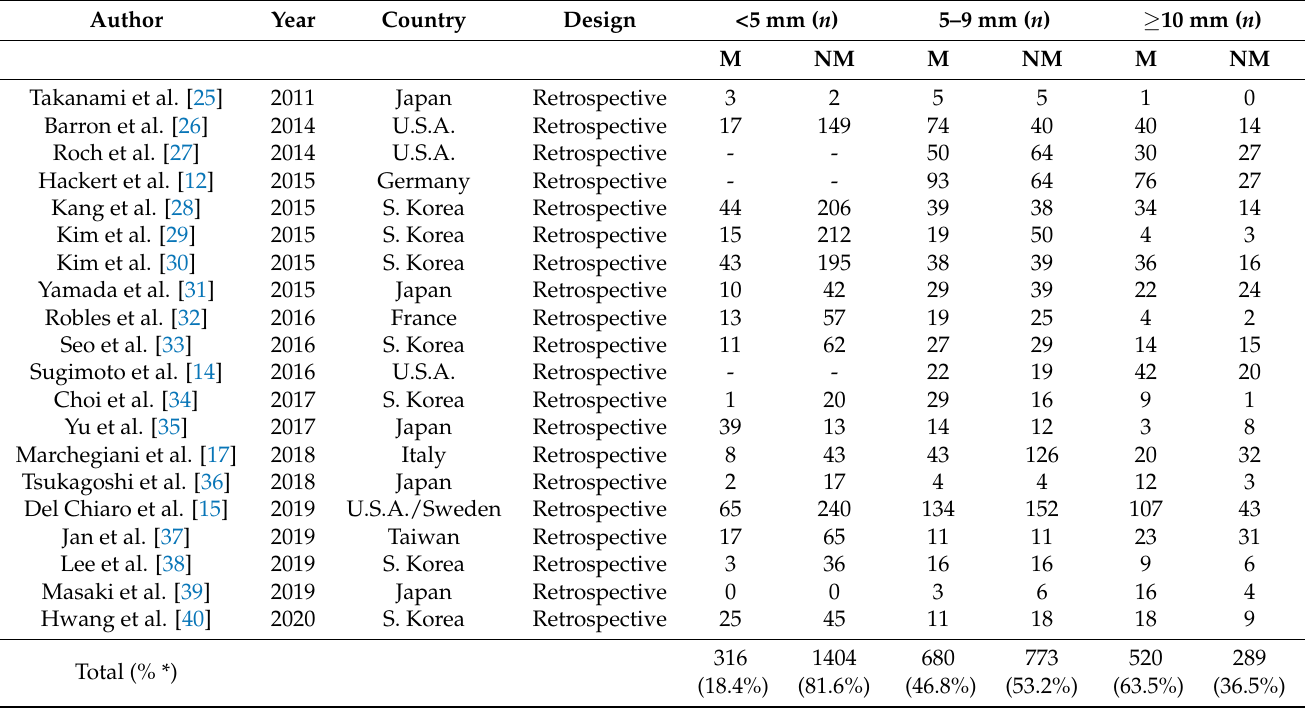
Table 1. Characteristics of included